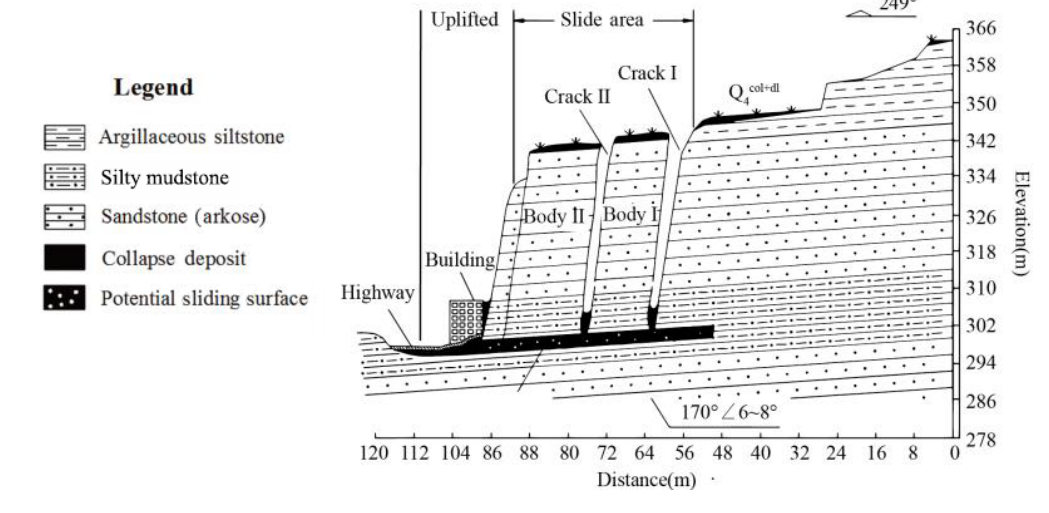
Figure 3. The I–I (cid:48) cross section of the